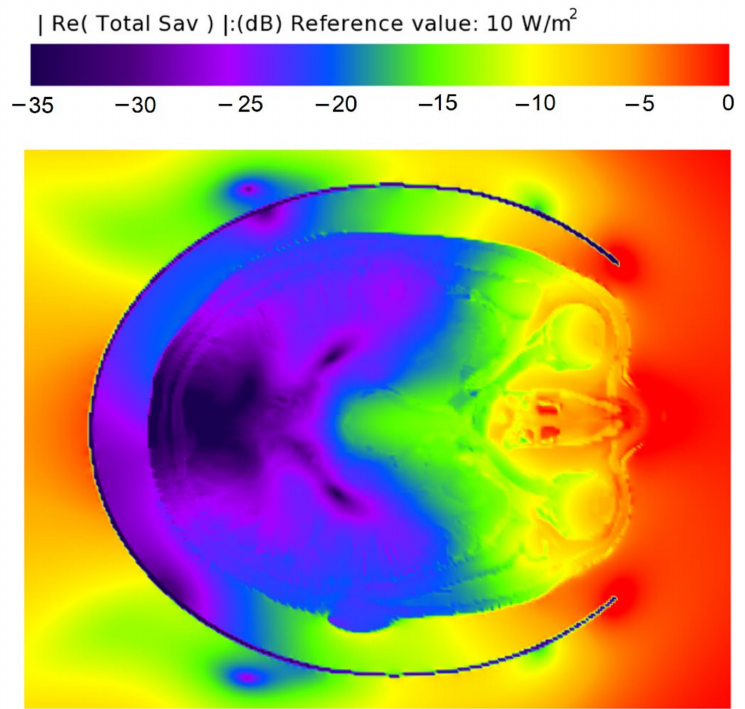
Figure 10. Power density for metal surface shield, 750 MHz (in the logarithmic scale with reference value equal to 10 W/m 2